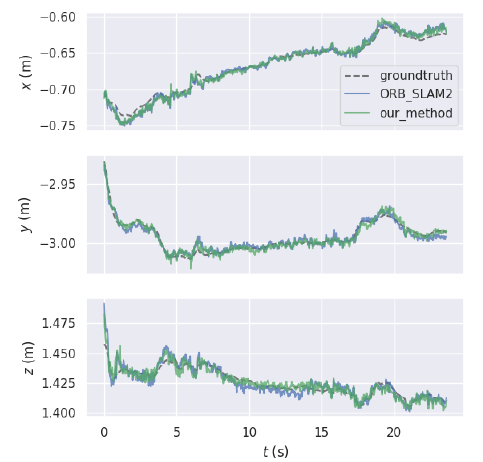
Figure 8. Euler angle of fr3_sitting_static predicted by ORB_SLAM2 and our